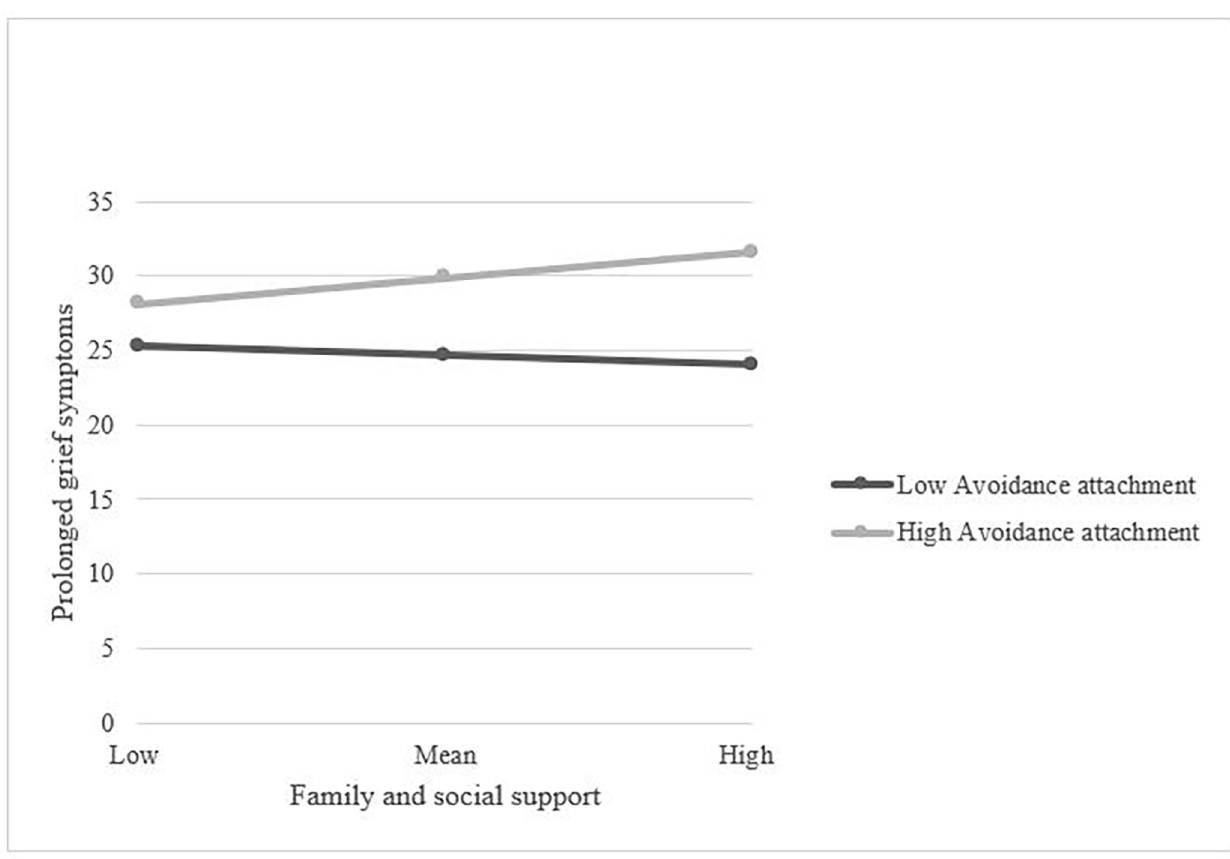
Fig 2. Interaction between perceived support and avoidance attachment for predicting prolonged grief symptoms among family caregivers.